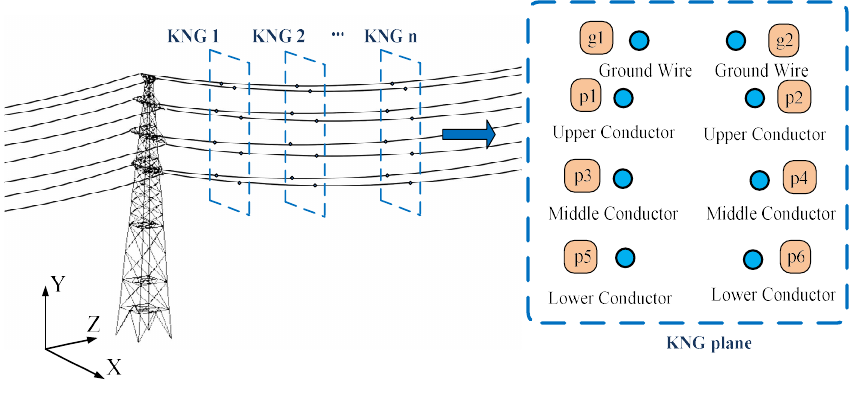
Figure 6. Schematic diagram of key-node method (KNM).